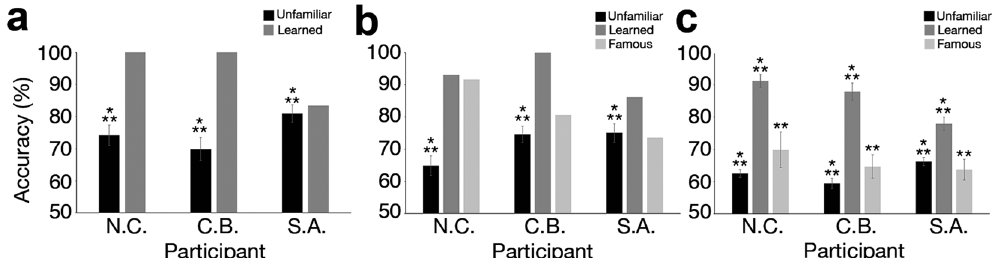
Figure 3. Average reconstruction accuracy for three participants (NC, CB and SA). Accuracy was estimated via ( a ) objective pixelwise similarity; ( b ) experimental data from the same participants, tested on their own reconstructions, and ( c ) experimental data from an independent group of participants (error bars show 1SE; ** p < 0.01 *** p <